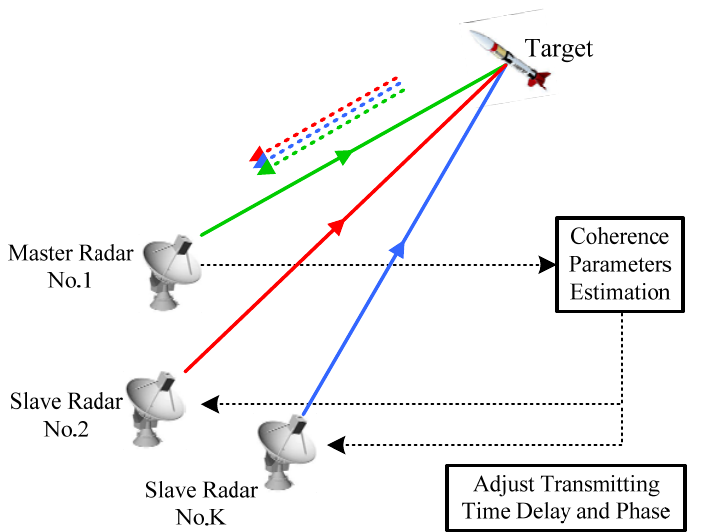
Figure 1. The master-slave architecture of